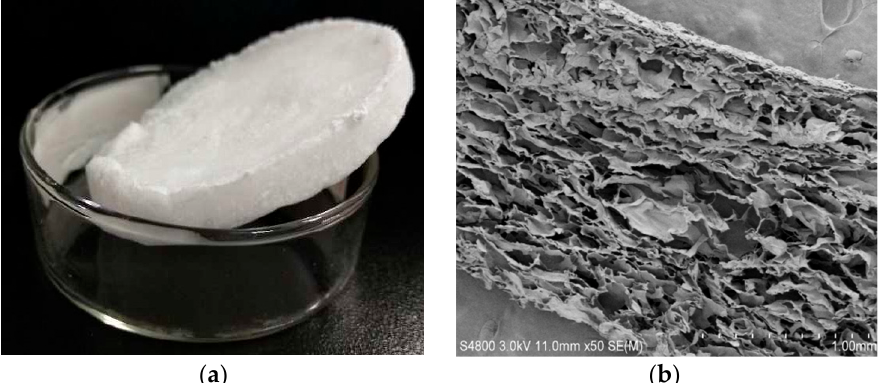
Figure 2. Sponge appearance (digital camera) ( a ) and internal structure (scanning electron microscope) ( b ).